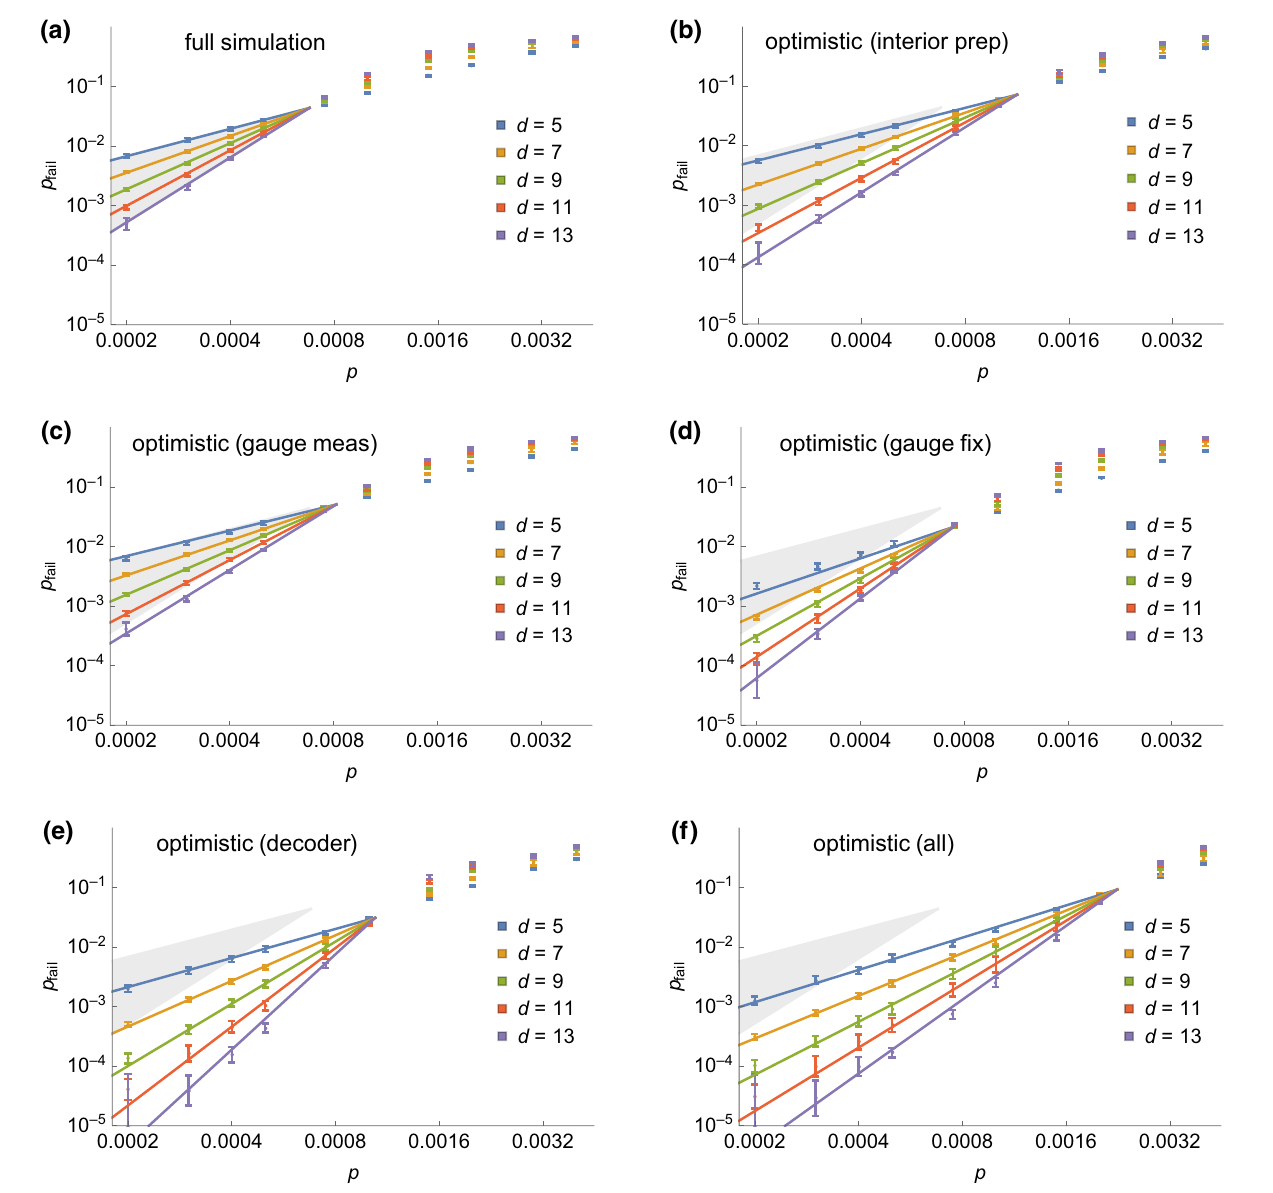
FIG. 30. (a) Failure probability of the code-switching protocol under circuit noise, for which we observe a T gate threshold of 0.07 ( 1 ) %. We also estimate the code-switching failure probability when one step, i.e., (b) interior preparation, (c) gauge measurement, (d) gauge fixing, and (e) the decoder, is replaced with an optimistic version. In (f), all four of these steps are replaced by their optimistic versions. We use a special form of the ansatz in Eq. (7), i.e., p fail = A between the fit lines from (a) is superimposed onto (b)–(f) to guide the eye. We observe that improving the interior preparation and developing a better decoder have the most potential to improve the performance of code switching. If all the potential improvements are achievable, the threshold could be as large as 0.22 ( 5 )